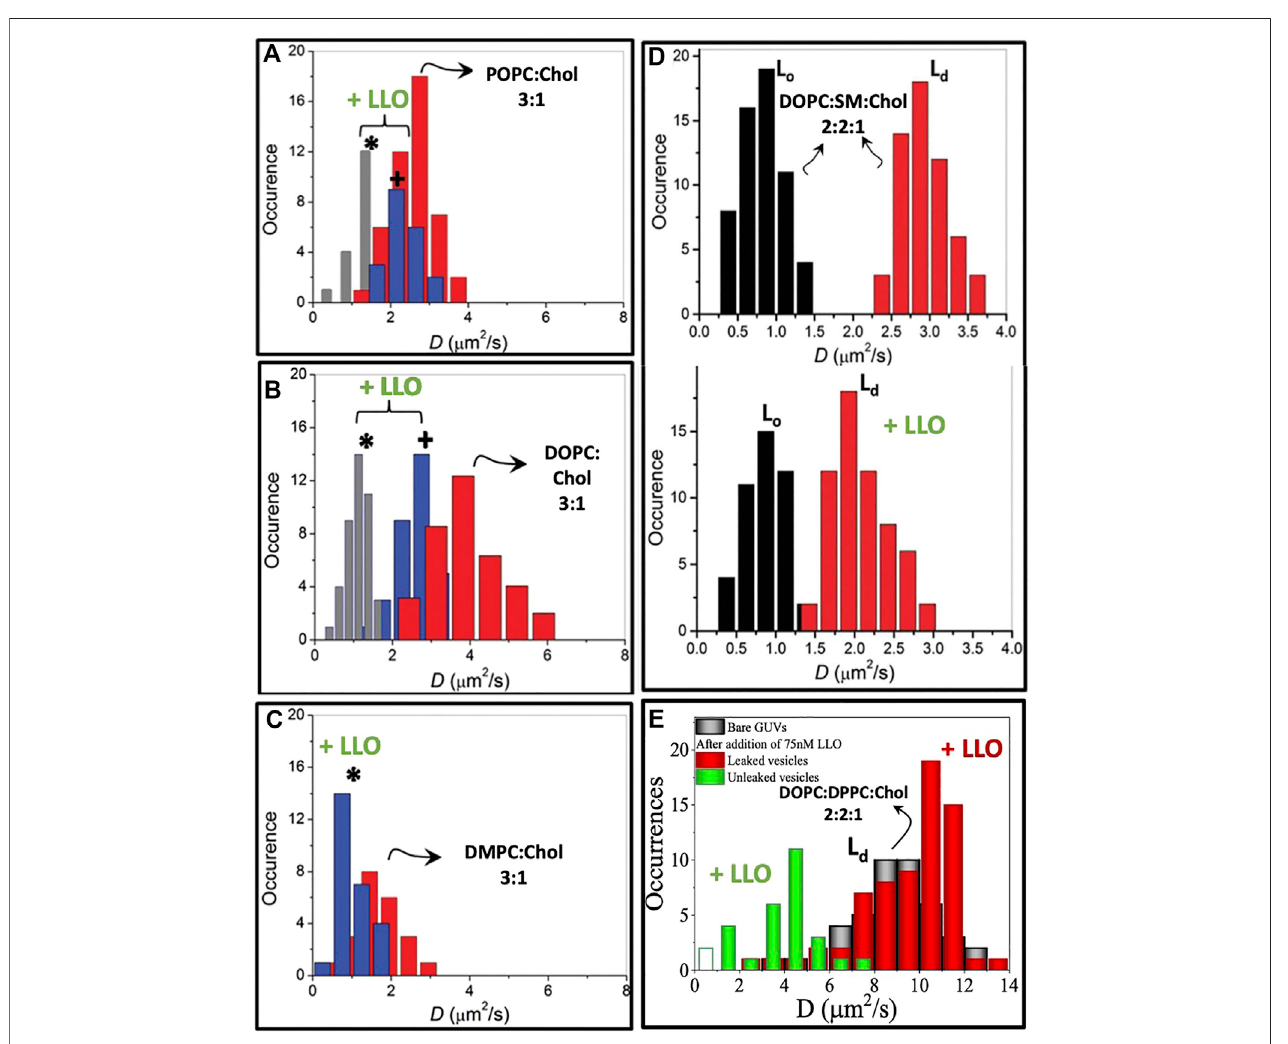
FIGURE 5 | Lipid diffusion coef fi cients D measured from lipid bilayers of different compositions using confocal FCS. Panels (A – C) demonstrate hindered bimodal lipiddiffusionobservedonSLBsofcompositionsPOPC,DOPCandDMPCwith25%cholesterolathighLLOconcentrationsof86.2 nM.Measurementscollectedinthe vicinityofthepore complex(*)and away fromthe pore complex(+). Adapted from Sarangiet al.(2016b). (D) . Inathree component lipid bilayer comprised ofDOPC:SM: Chol, the changes in the lipid diffusion upon LLO interaction is observed speci fi cally on the L d domain. Adapted from Sarangi and Basu (2018). (E) . Lipid D measured on L d domain of DOPC:DPPC:Chol GUVs indicating bimodal distribution in leaked and unleaked vesicles. Reproduced from Ponmalar et al. (2019).